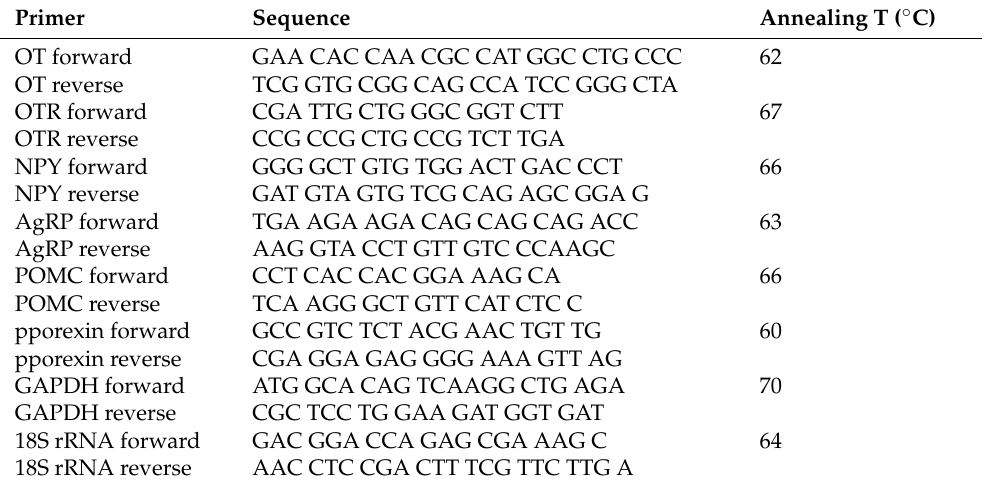
Table 1. Primer sequences, product sizes, and annealing